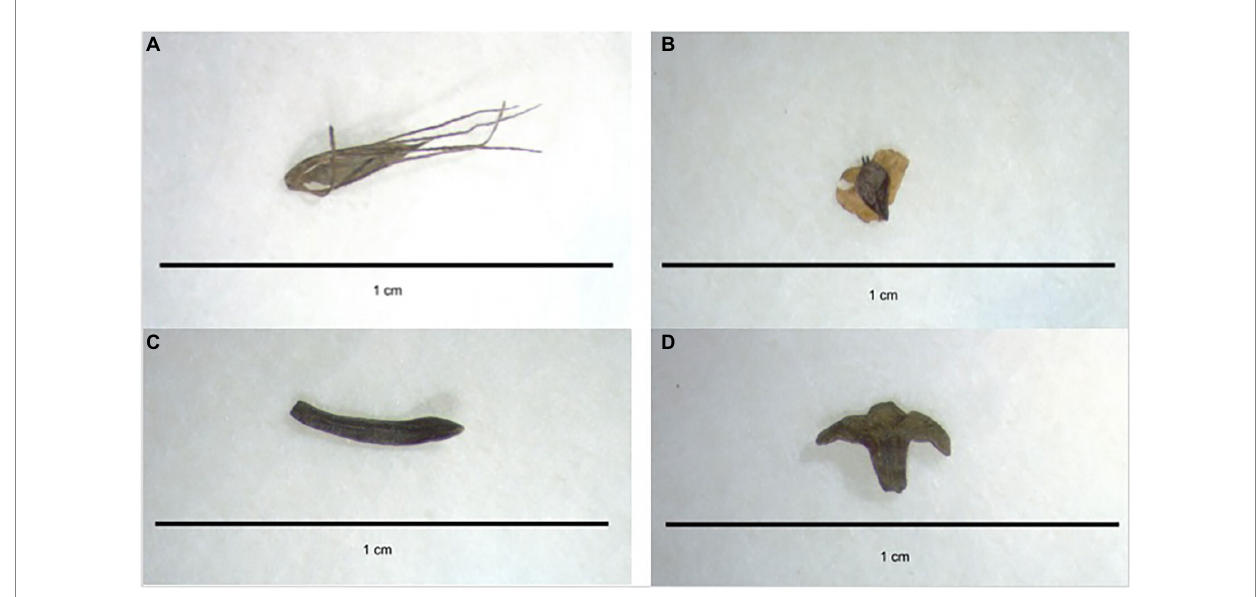
FIGURE 3 Photos of macrofossils from the Sargent Mountain Pond core, with the depth found included in parentheses: (A) Cyperaceae achene (287.5 cm), (B) Betula sp. seed (260 cm), (C) Picea sp. needle (375 cm), and (D) Betula sp. catkin scale (272.5 cm).